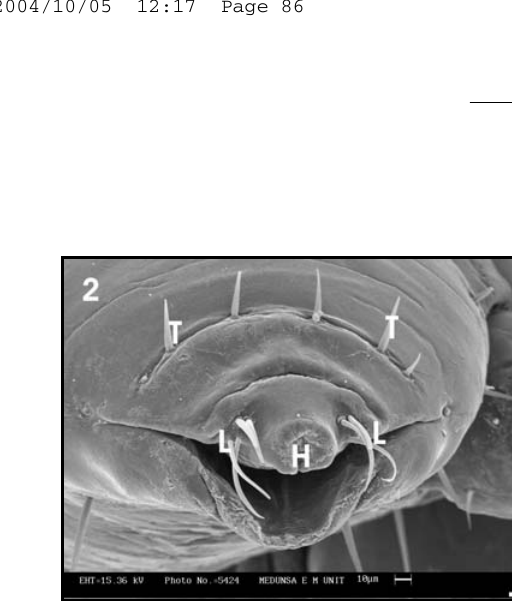
Fig. 2. The haustellum (H), two pairs of laterally (L) situated setae and six short transverse (T) setae.